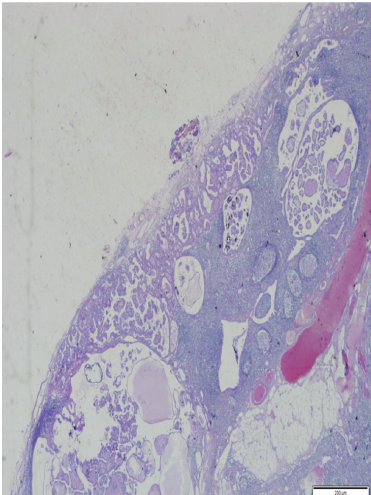
Figure 4: Papillary structures are laid down by laminated cells with clear nucleus (H&E ×